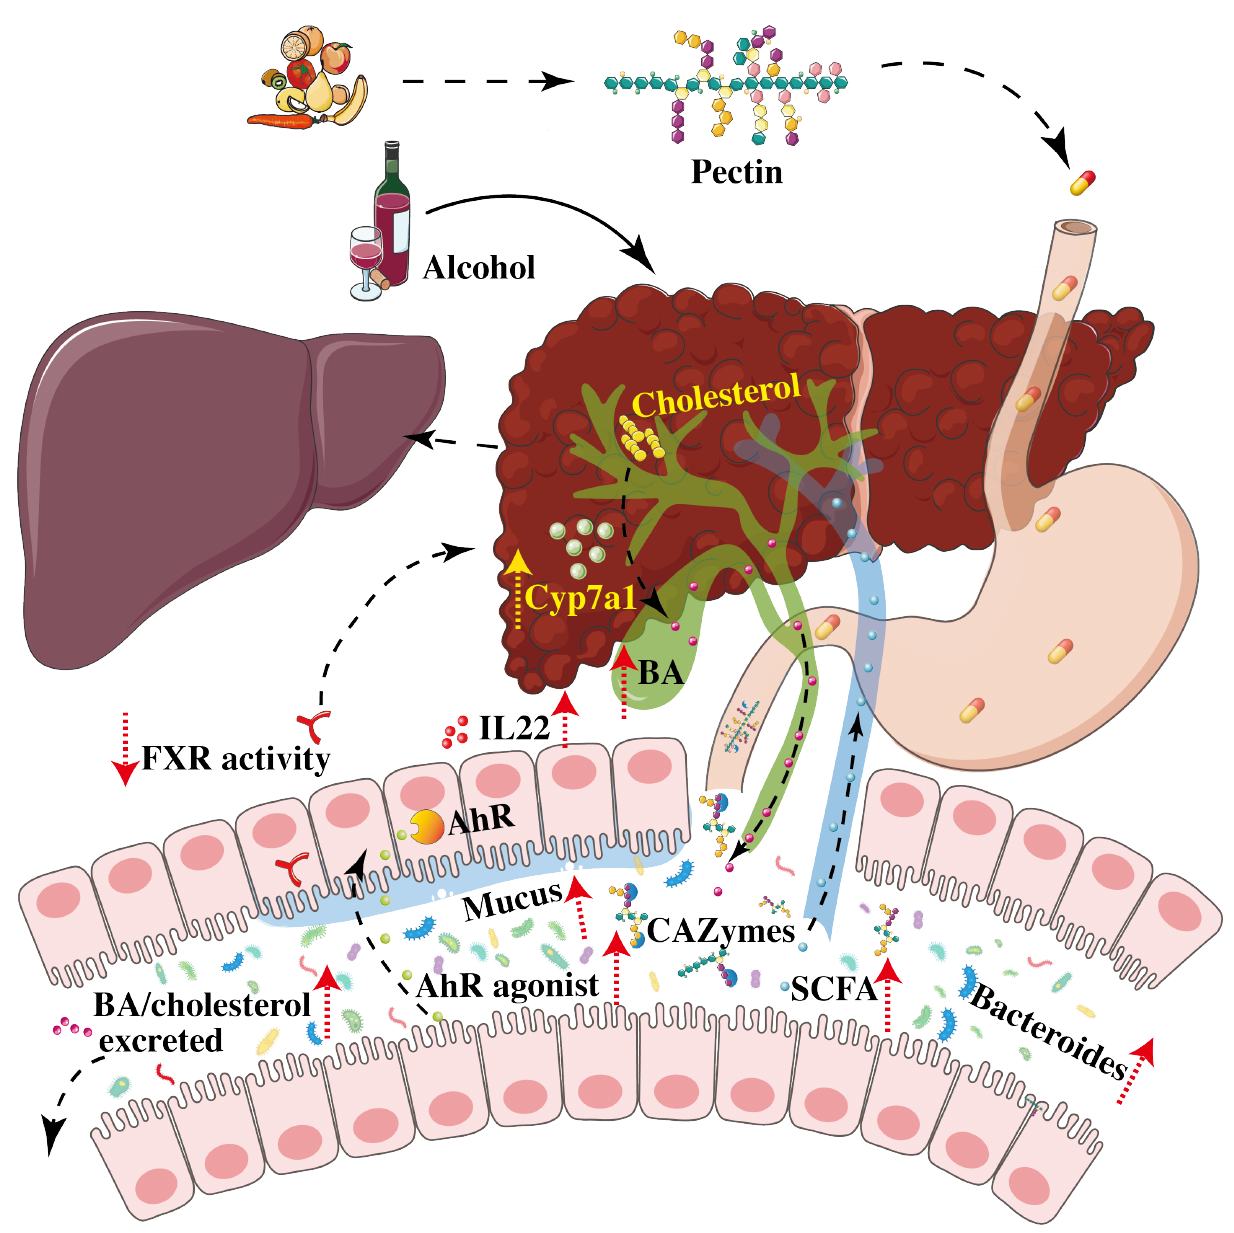
Figure 3. Graphical summary of mechanisms involved in changes induced by pectin in alcoholic liver disease (ALD). Complex polysaccharides of pectin are broken-down by CAZymes expressed by gut bacteria to make pectin work. Pectin increased in Bacteroides, SCFA, and indole derivatives, such as AhR agonists. Pectin increases liver BA synthesis by decreasing FXR activity and increasing the level of Cyp7a1, which promotes the conversion of cholesterol to BA. The dotted line represents the pectin treatment process and the solid line represents the liver injury process. Abbreviations: AhR, aryl hydrocarbon receptor; BA, bile acid; CAZymes, carbohydrate active enzymes; Cyp7a1, cholesterol 7 α -hydroxylase 1; FXR, farnesoid X receptor; SCFA, short-chain fatty